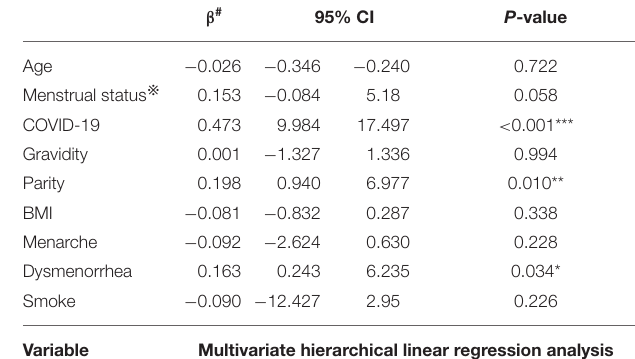
TABLE 3 | Linear regression for association of COVID-19 disease with sex hormone T. Univariate linear analysis